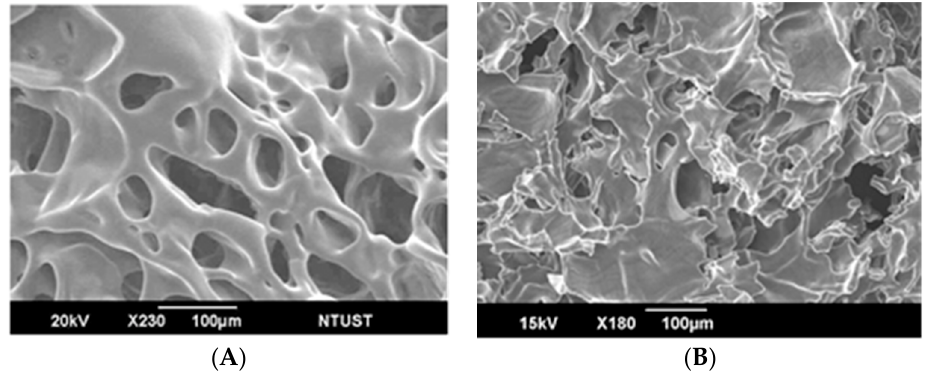
Figure 7. Examinations of the hydrogel combined with IMQ-containing liposomes by scanning electron microscopy: ( A ) pure PF127 and ( B ) PF127 mixed with IMQ-containing liposomes.